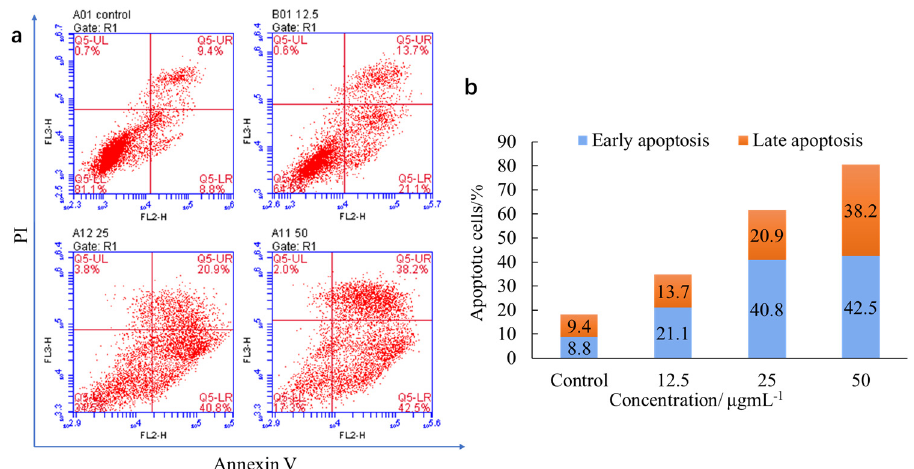
Figure 3. Apoptosis assay of HepG2 cells treated with L 1 . ( a ) The control was HepG2 cells treated with DMSO (negative control), followed by L 1 at 12.5, 25, and 50 μ g/mL. ( b ) Apoptotic rate of control and L 1 at 12.5, 25, and 50 μ g/mL, including early apoptosis and late apoptosis. After L 1 was incubated with HepG2 cells with the concentration range from 12.5 to